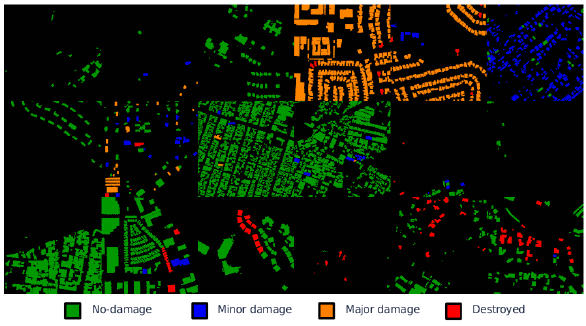
Figure 3. Ground truth for xView2 images